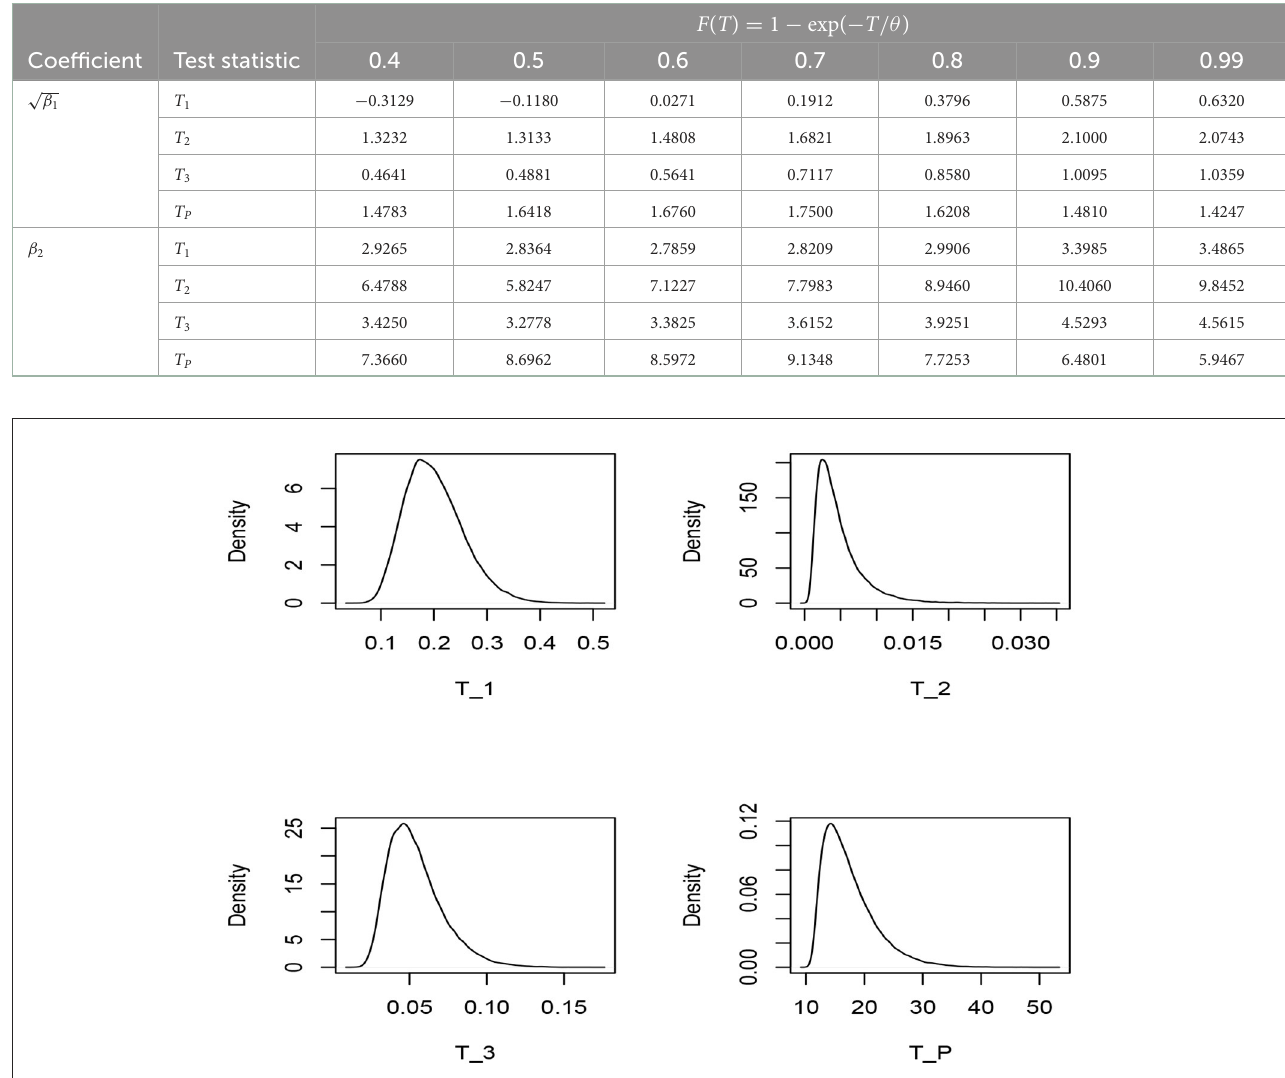
FIGURE1 Monte Carlo simulated pdf curves for the test statistics T 1 , T 2 , T 3 , and T P under the assumption of exponential model.